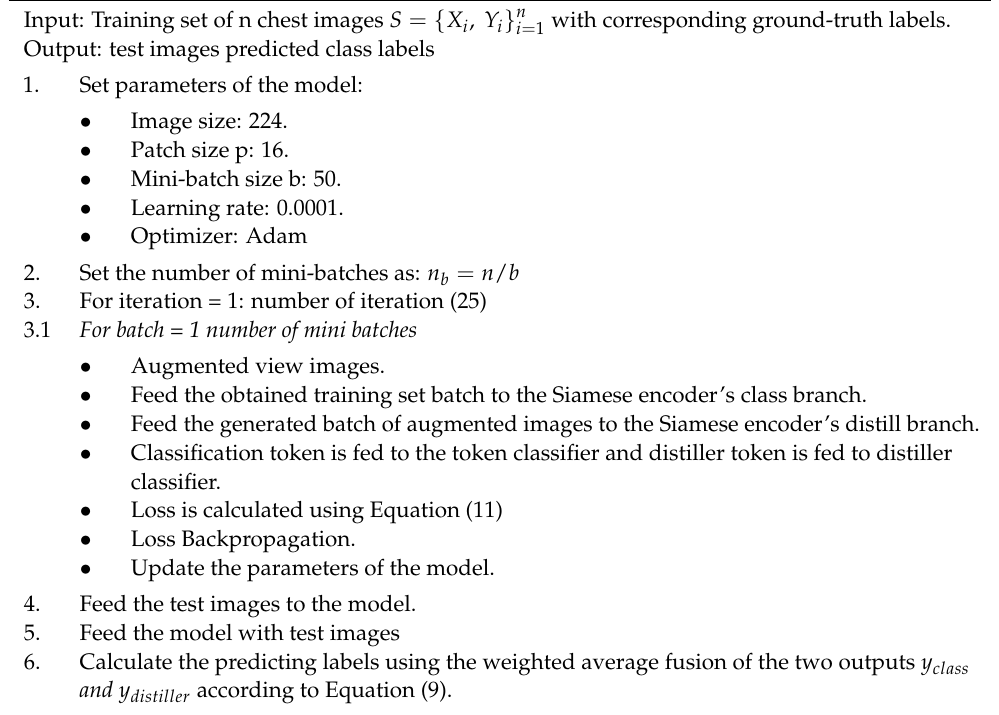
Algorithm 1: Main steps for training and testing the